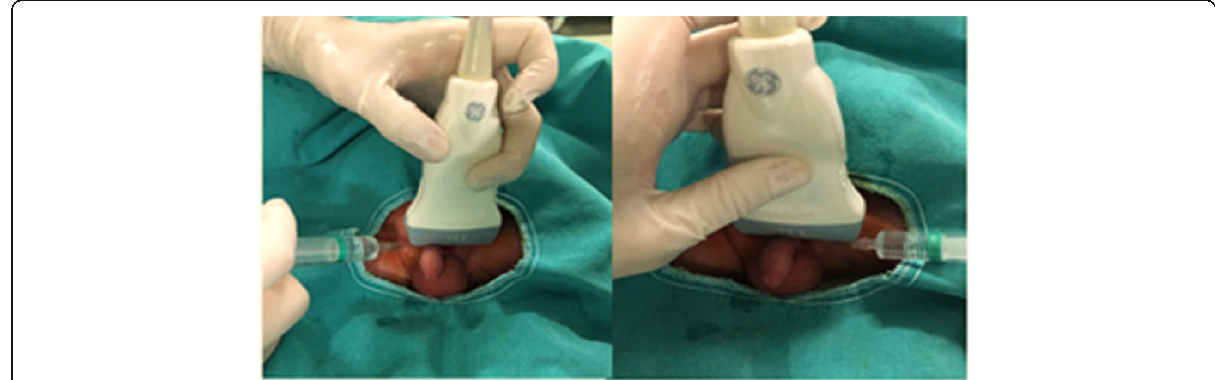
Fig. 1 Anesthesiologist approach: ultrasound-guided (in-plane method) penile